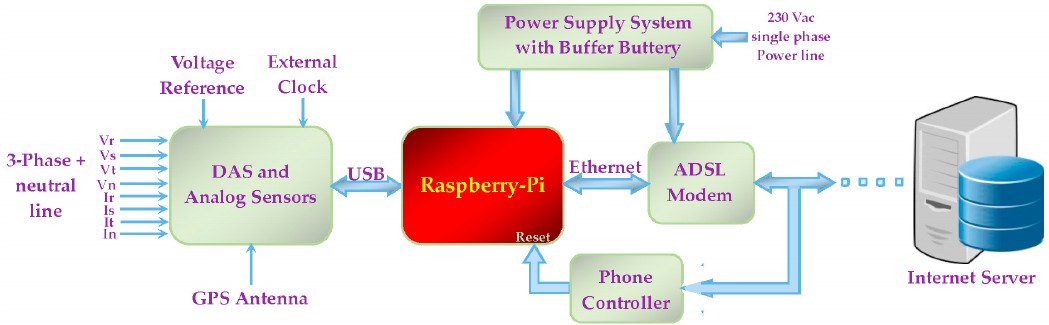
Figure 4. Block scheme of the PQ measurement device.